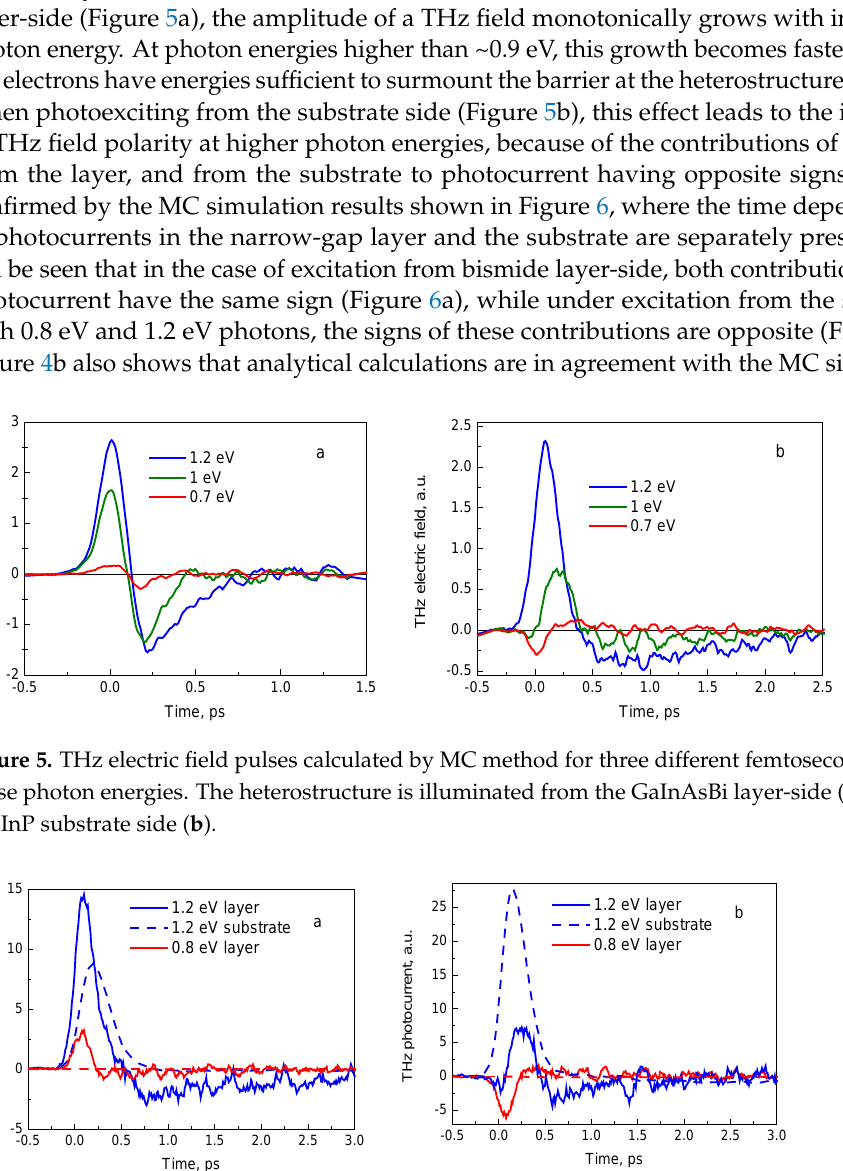
Figure 6. The MC calculated contributions of GaInAsBi layer (solid lines) and InP substrate (dashed lines) to the photocurrent for a heterojunction excited by femtosecond pulse optical radiation from the top layer ( a ) and from the substrate side ( b ); the blue and red lines correspond to the photon energies of 0.8 and 1.2 eV, respectively. The photocurrent in the substrate at 0.8 eV is zero.